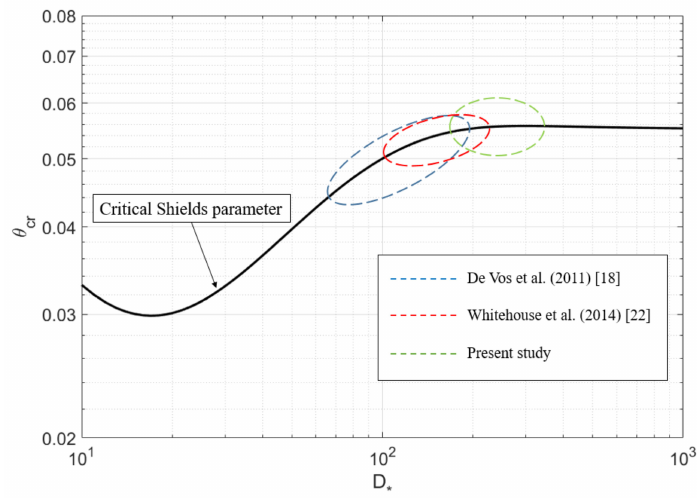
Figure 9. Range of D ∗ in di ff erent experiments on the Soulsby’s critical Shields parameter